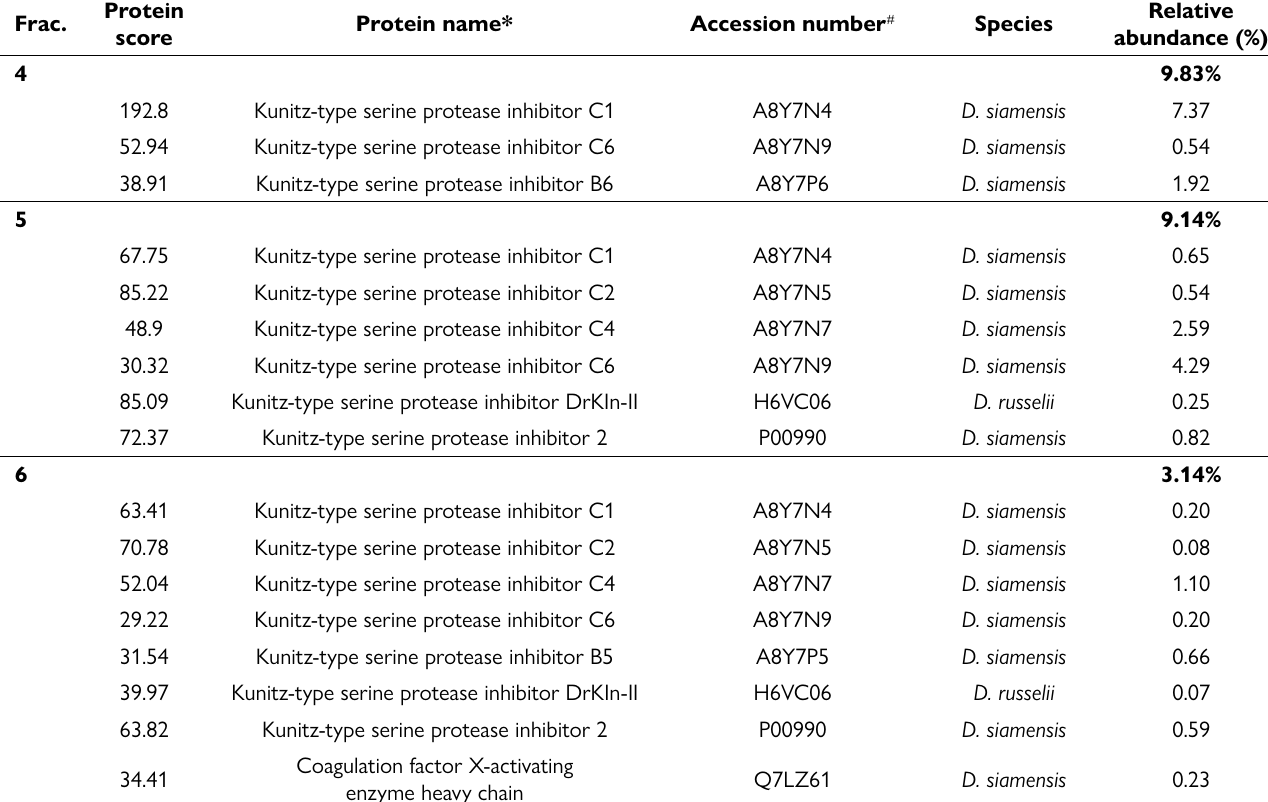
Figure 2. Venom proteomes of Daboia siamensis from (A) Thailand and (B) Indonesia. KSPI: Kunitz-type serine protease inhibitor; PLA snaclec: snake venom C-type lectin/lectin-like protein; SVSP: snake venom serine protease; SVMP: snake venom metalloproteinase; LAAO: L-amino acid oxidase; VEGF: snake venom vascular endothelial growth factor; VNGF: snake venom nerve growth factor; 5′NUC: 5′-nucleotidase; PDE: phosphodiesterase; Dis: disintegrin. Table 1. Venom proteins of Daboia siamensis (Thailand) assigned by fractions of reverse-phase HPLC. Data derived from LC-MS/MS analysis of the tryptic peptides